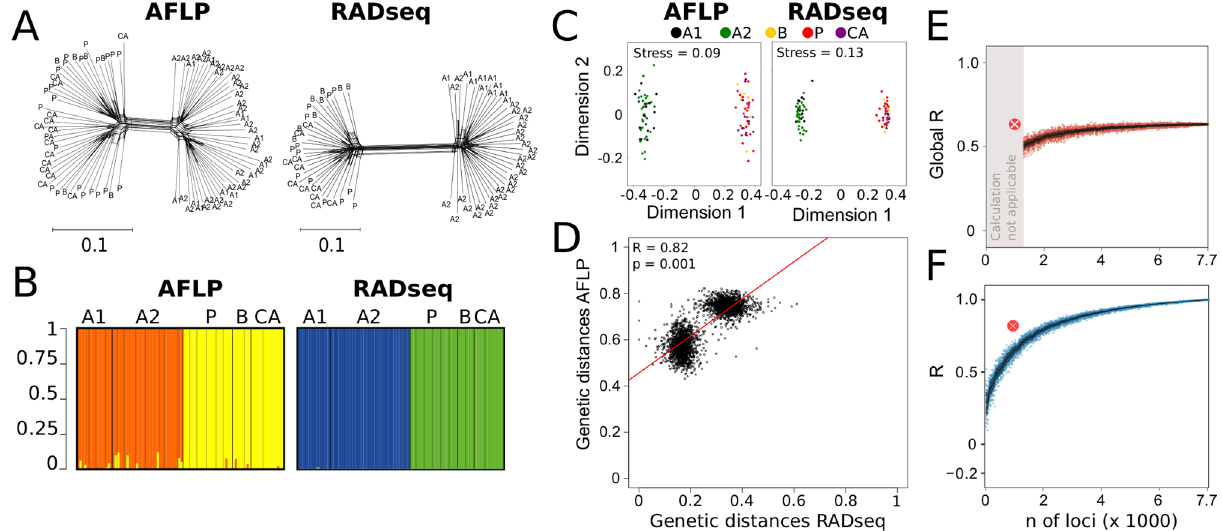
Figure 3. Comparative analyses based on the large Omocestus petraeus amplified fragment length polymorphism (AFLP) and restriction site associated DNA sequencing (RADseq) datasets. Abbreviations in A-C reflect the geographic origin of the samples: A1 = Western Alps, A2 = Eastern Alps, B = southeastern Balkan Peninsula, CA = Central Asia, P = Pannonia ( A ) NeighborNets inferred from AFLP data and RADseq data. ( B ) Bar plots show the two genetic groups identified via Bayesian clustering. Each bar represents one individual, colors show proportion of affiliation to a cluster. ( C ) Ordination plots of AFLP and RADseq data retrieved from non-metric multidimensional scaling (NMDS). ( D ) Correlation plots of AFLP and RADseq derived distance matrices. Mantel R and corresponding significance levels are shown in the plot. ( E ) Global R values calculated via analysis of similarity (ANOSIM) derived from the down-sampled RADseq matrices. Each point represents one randomly down-sampled observation; colored points are significant observations, grey points are non- significant. Large orange points show calculations based on the number of available AFLP loci. ( F ) Correlation coefficient R calculated via Mantel matrix correlation of the down-sampled RADseq matrices and the full RADseq matrix. Each point represents one randomly down-sampled observation; colored points are significant observations, grey points are non-significant. Larger points show calculations based on the number of available AFLP